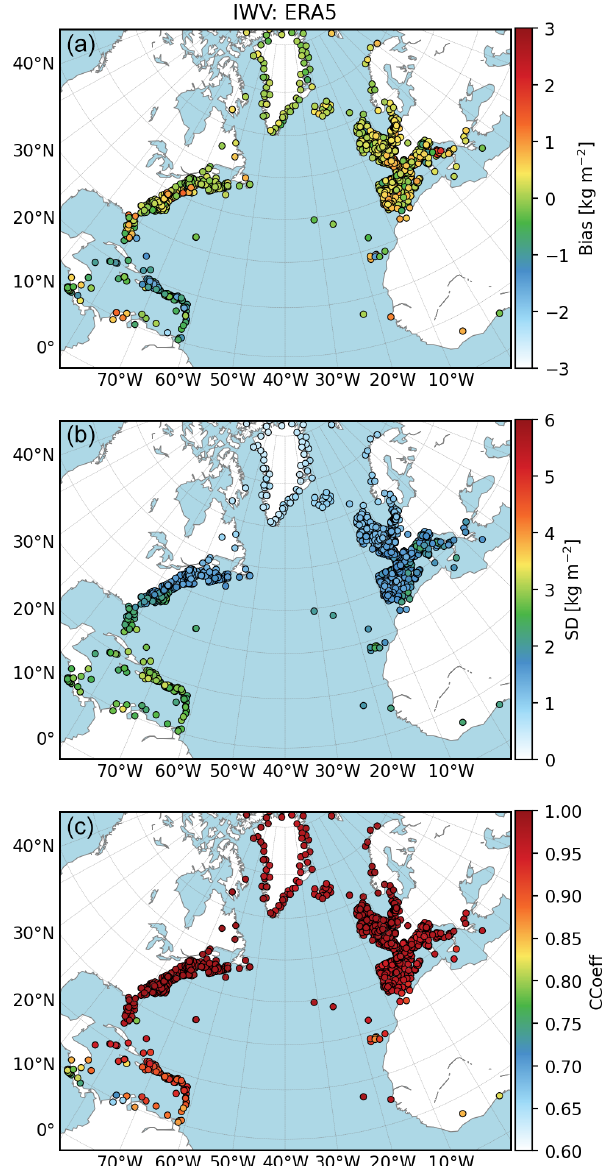
Figure 4. Maps of comparisons between ERAI and GNSS IWV for all stations. From (a) to (c) , bias (kgm − 2 , reanalysis minus GNSS), standard-deviation (kgm − 2 ) and correlation coefficient.